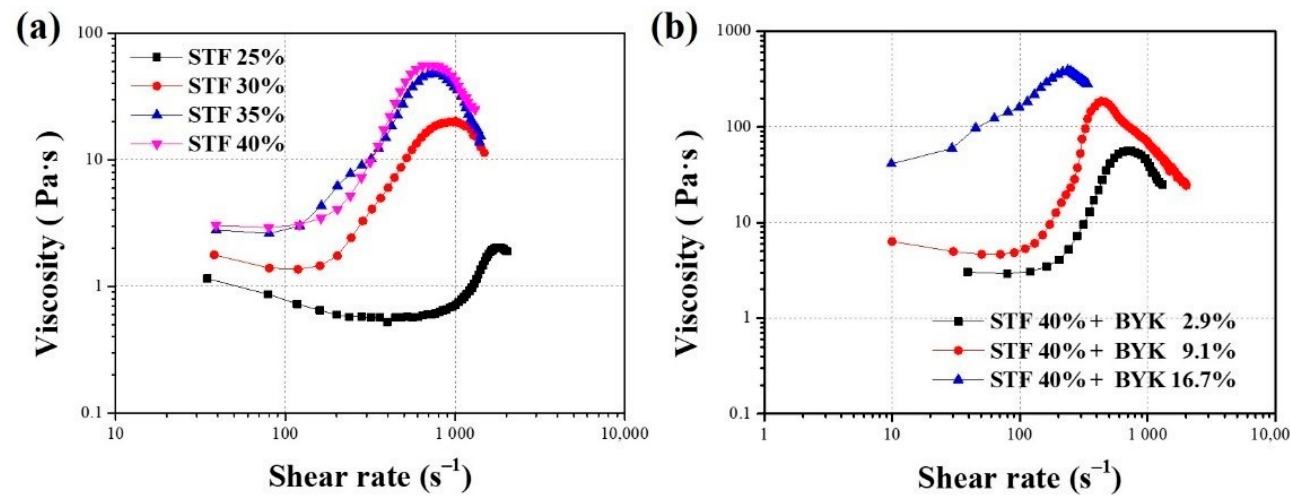
Figure 5. Rheology graph for as-prepared STF sample ( a ) STF rheological curves with different solid contents ( b ) The rheological curve of STF with 40% solid content and different content of dispersant.